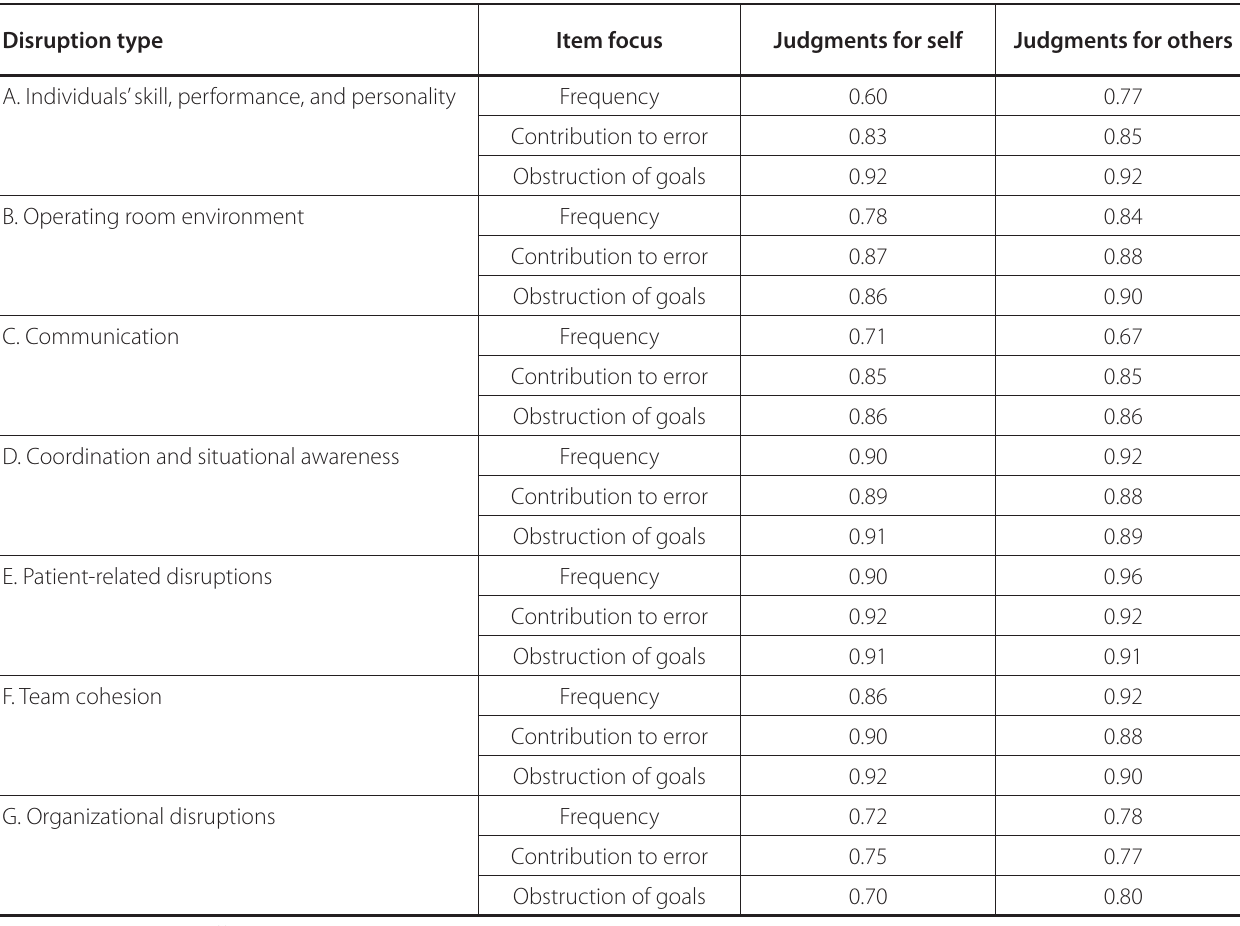
Table 3 . Reliability analyses of self-judgments and judgments for others* (n=